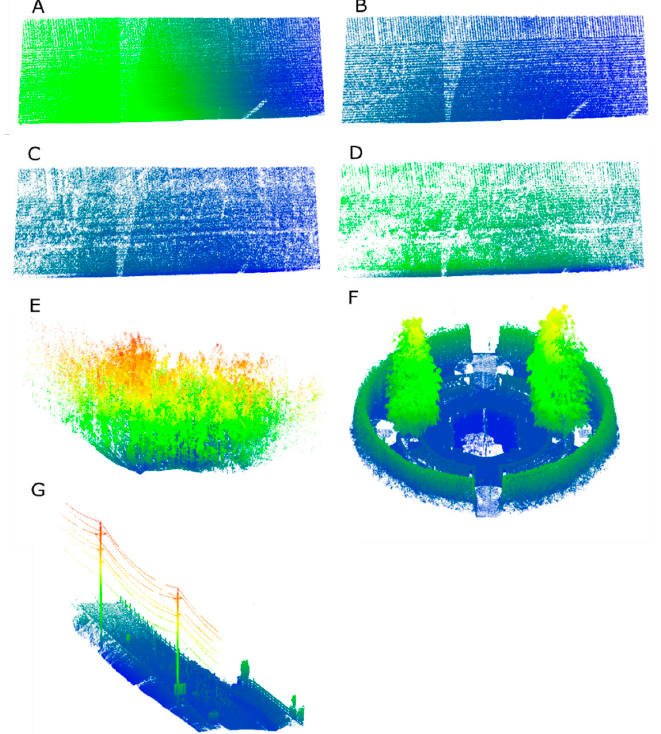
Figure 1. Point cloud heightmaps for the unclassified very low corn ( A ), low corn ( B ), medium corn ( C ), high corn ( D ), vegetated ( E ), garden ( F ), and road ( G ) study sites.